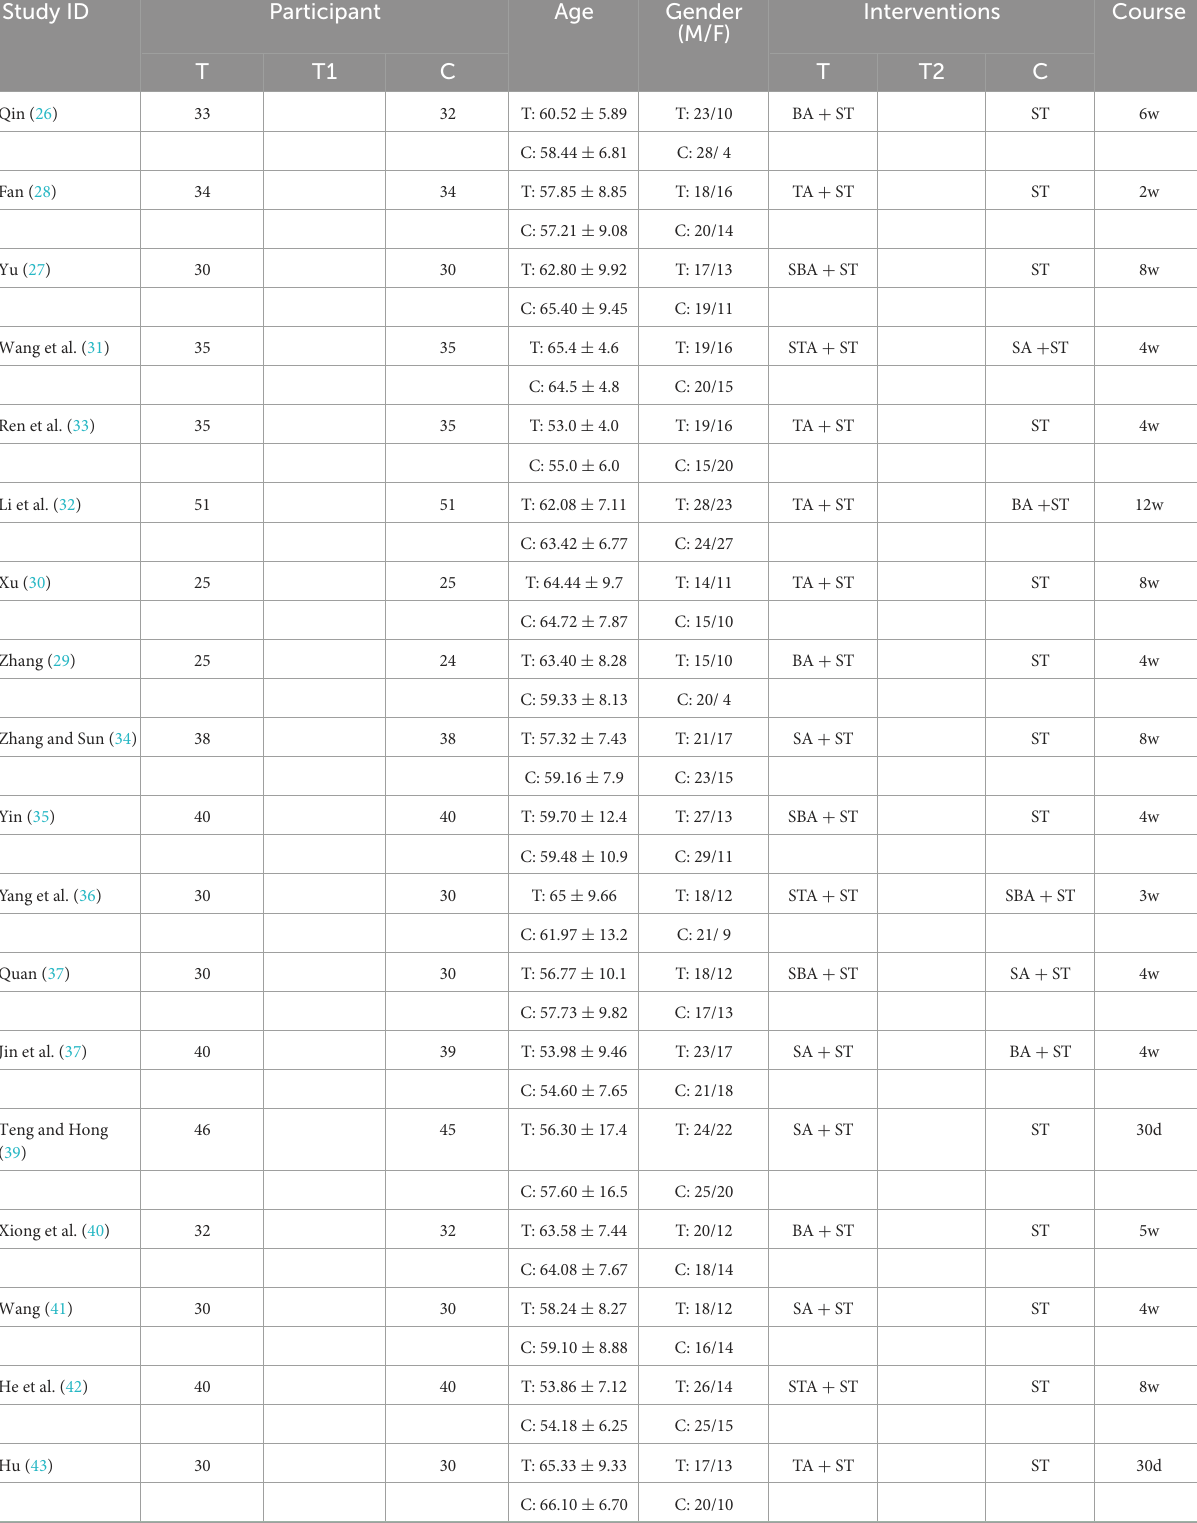
TABLE 1 Characteristics of included